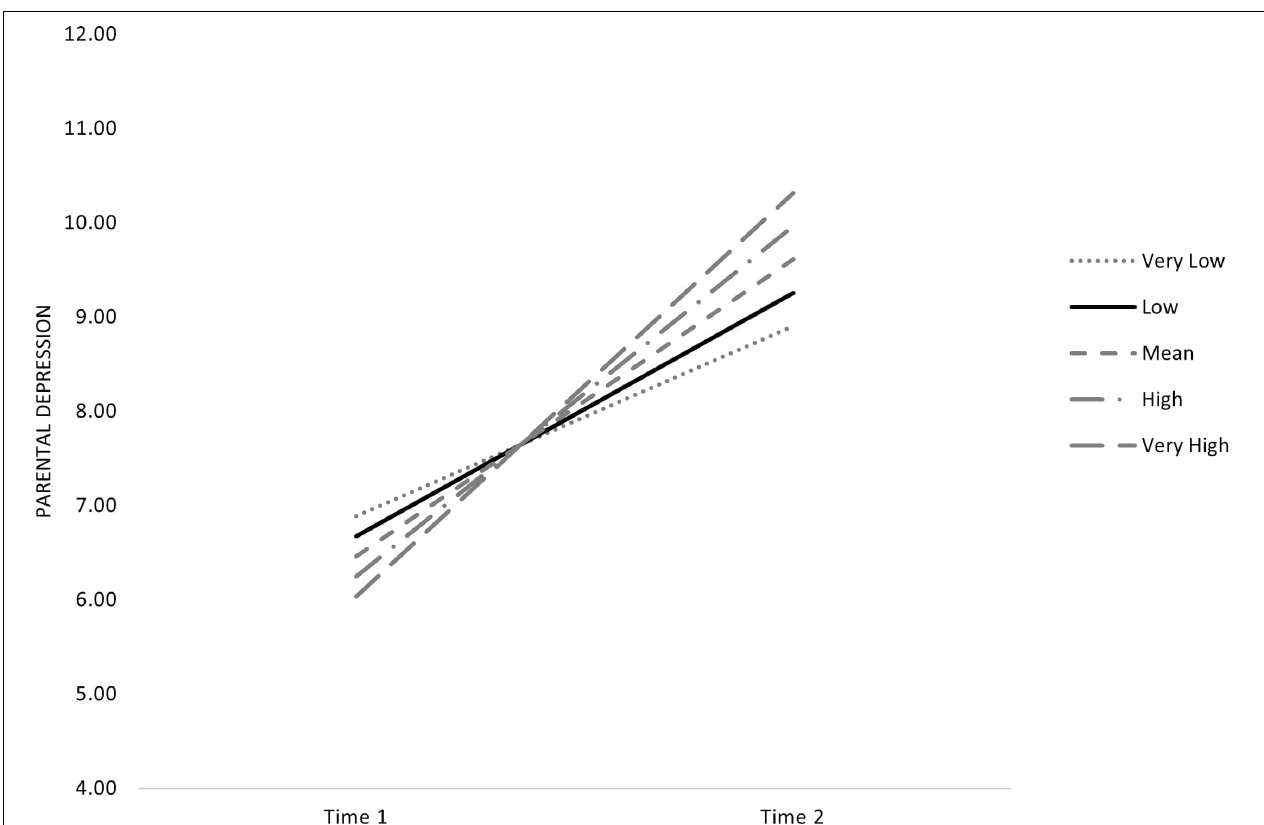
FIGURE 2 | Changes in parental depression according to economic